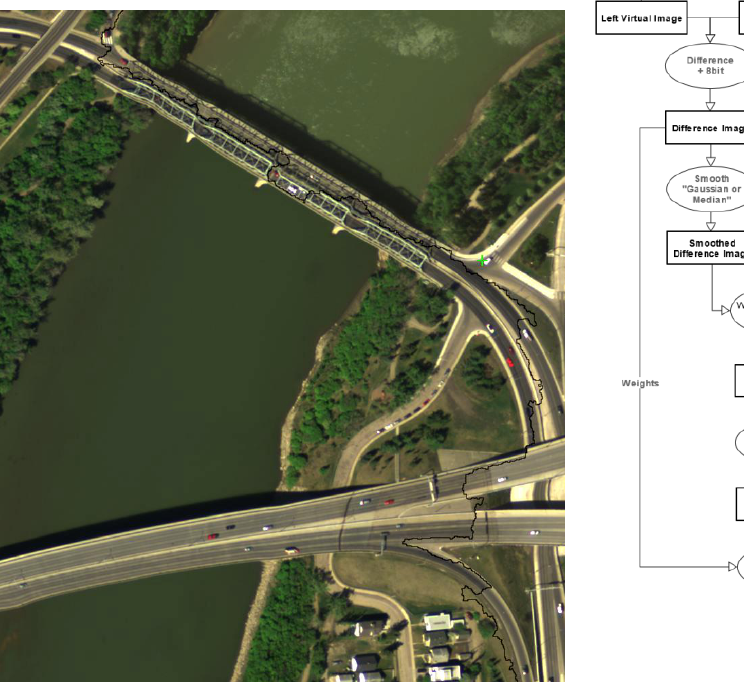
Figure 11.(c) A seamline example passing next to a bridge